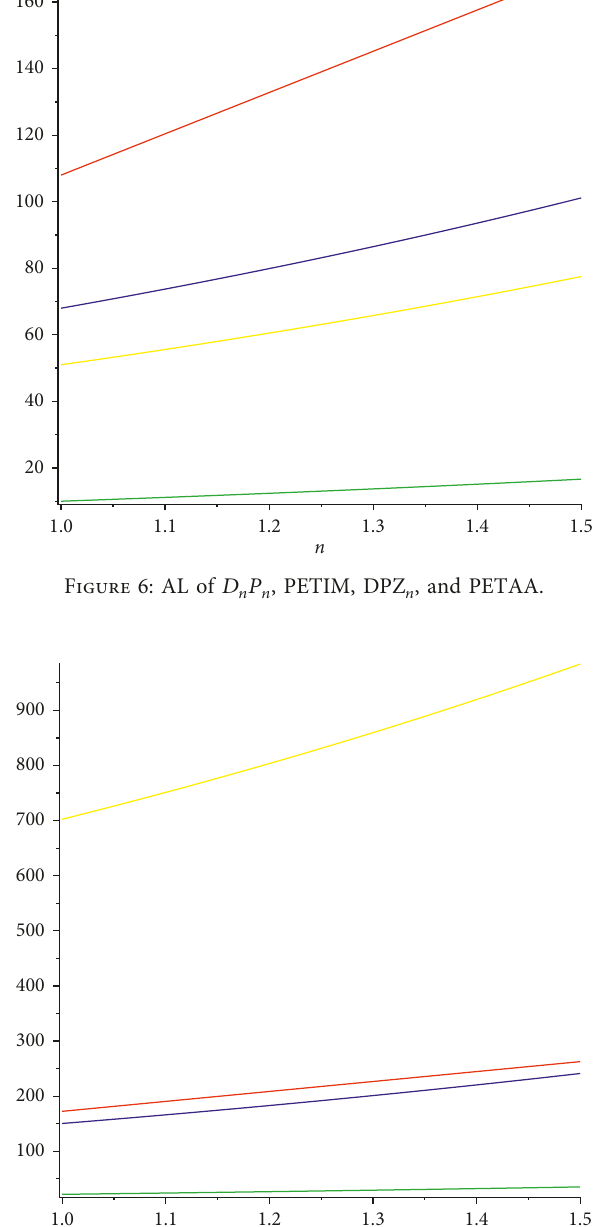
P n n , PETIM, DPZ n , and